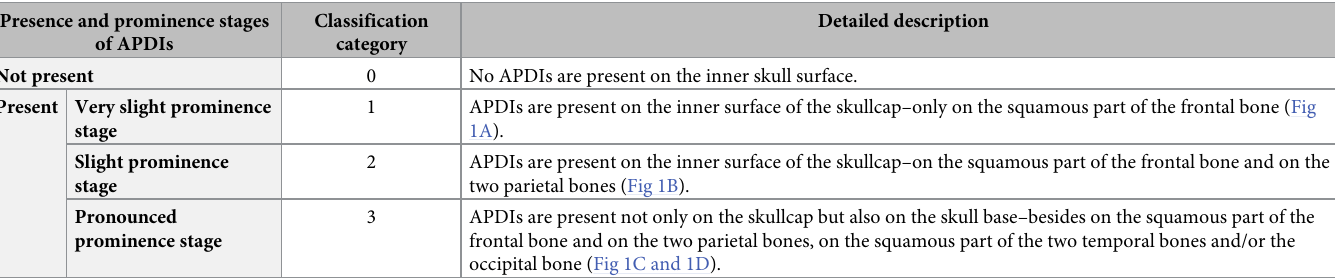
Table 1. Classification criteria for the presence of APDIs, considering the different prominence stages. Presence and prominence stages Classification of APDIs